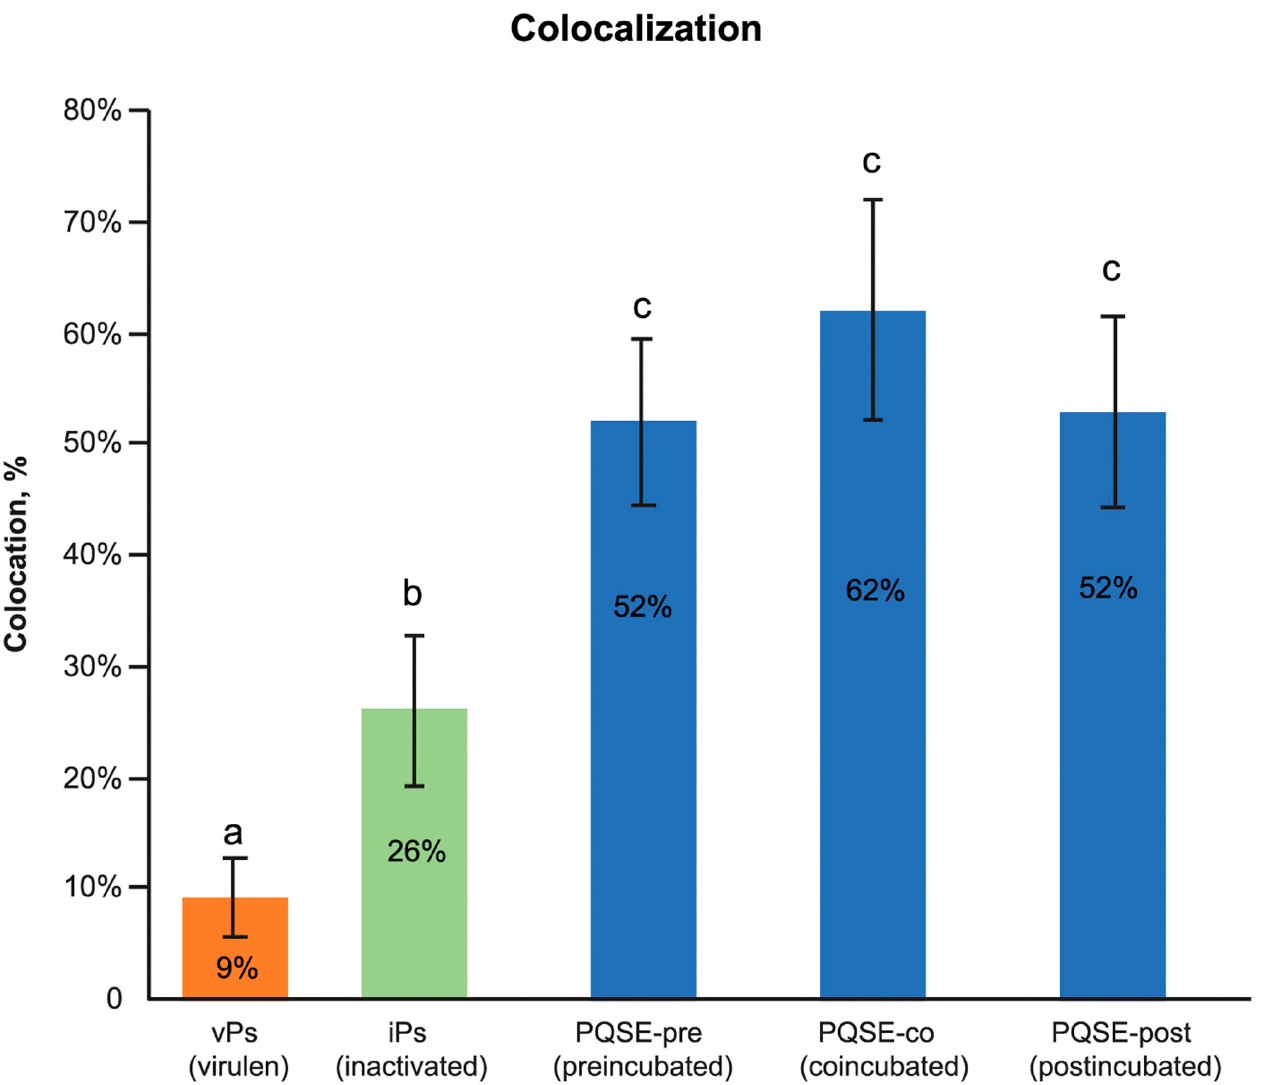
Figure 10. Colocalization of P. salmonis with lysosomes, in SHk-1 under Quillaja (PQSE). Intracellular localization of P. salmonis LF89 strains within SHK-1 macrophages was evaluated by confocal microscopy under three PQSE addition strategies. For the cell count, the design included 5 Treatments, 2 Rep/Treatment, 3 fields/Rep and 20 cells/field, for a total of 60 cells/Rep and 120 cells/treatment. It is observed that the treatments with the addition of 0.5 µ g/mL of PQSE to the cells, independent of the time of its addition (Pre, Co, or post challenge with vPs), colocalized significantly more than the inactivated (iPs) and virulent (vPs) P. salmonis . No statistical differences ( p > 0.05) were observed between the three PQSE addition strategies. The lowest colocalization was observed in cells challenged with the virulent strain (vPs), without PQSE. Different letters a, b and c depict statistically significant differences ( p < 0.05).